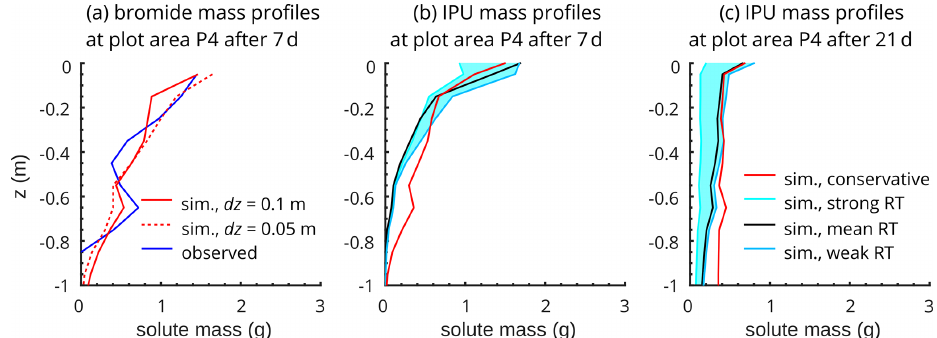
Figure 6. (a) LAST-Model results of 7d simulation with bromide and different soil domain discretization d z at site P4. Panels (b) and (c) show hypothetical results of a 7 and 21d simulation with a weak and strong reactive transport configuration for IPU (cf. Table 2, Sect. 4.2.3) at site P4. The bright blue range between the two profiles demonstrates a hypothetical and possible range of IPU mass profiles under the influence of retardation and degradation during 7 and 21d at this site, respectively. The black profiles additionally show results with a mean reactive transport configuration (cf. Table